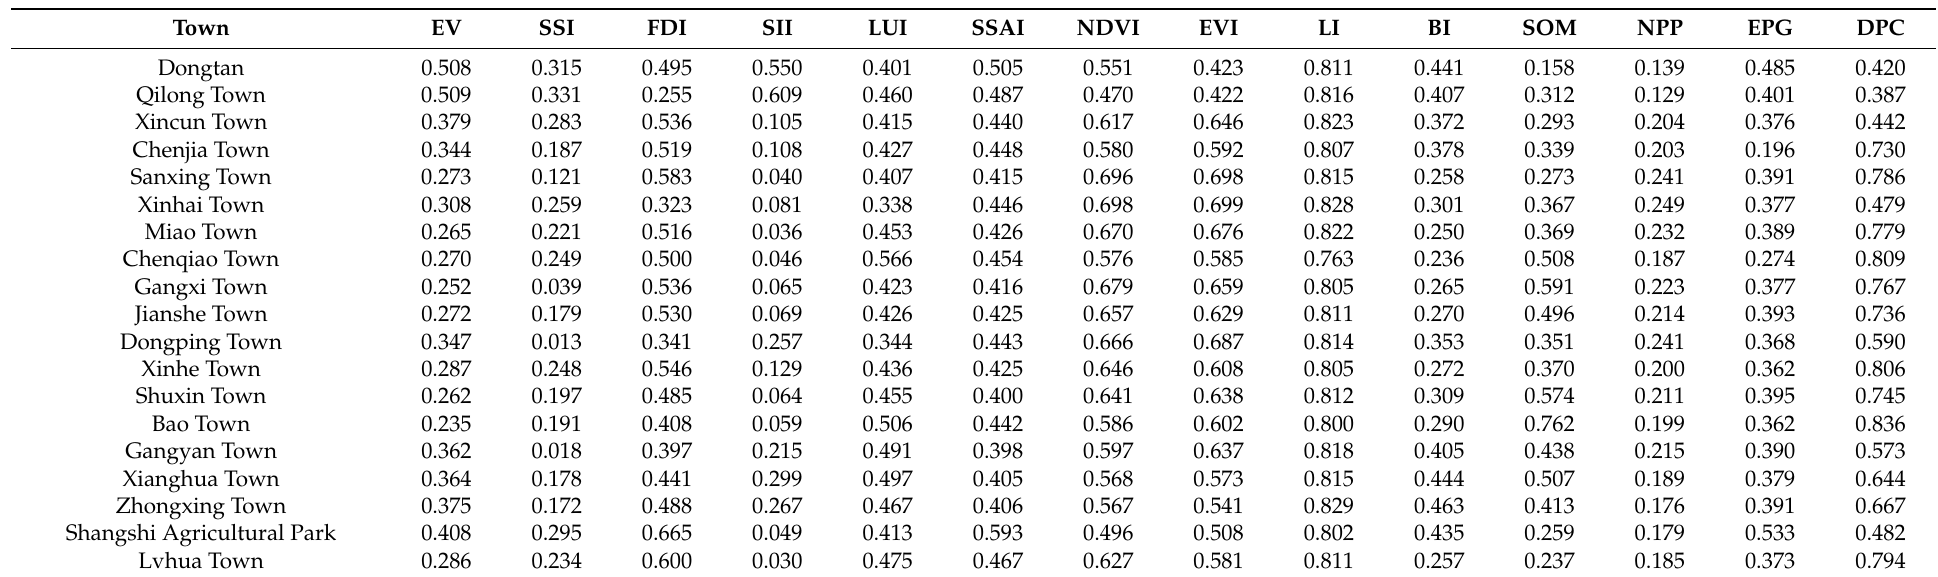
Table A6. The ecological vulnerability of each town in